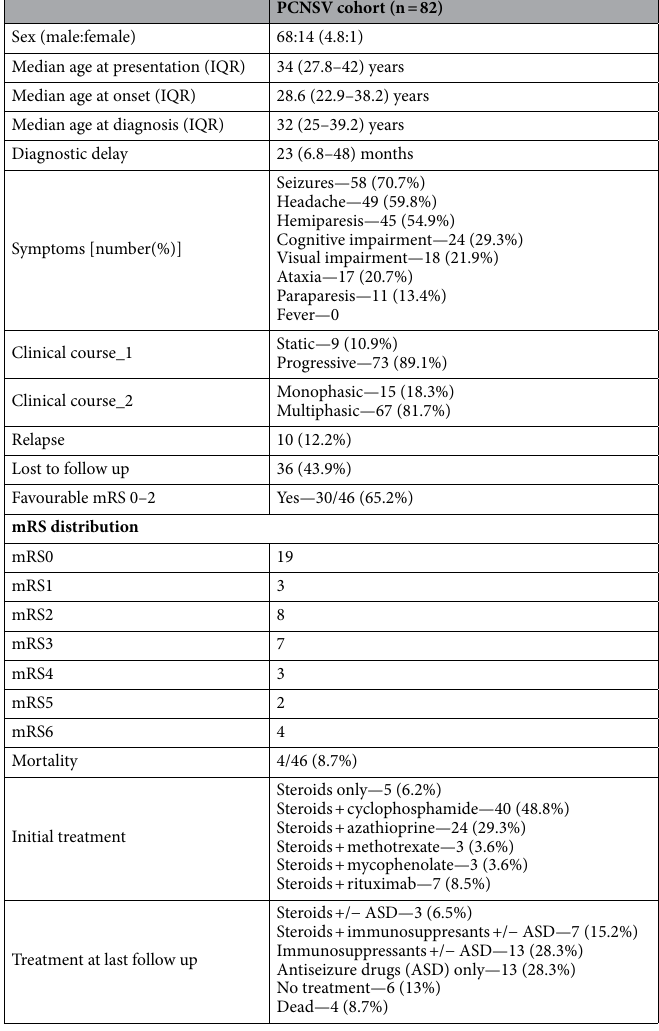
Table 1. Clinical characteristics.